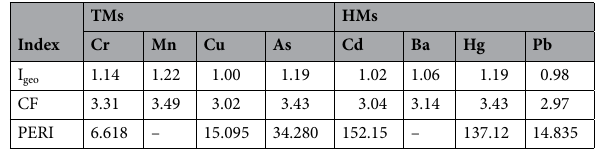
Table 5. Geo-accumulation index (I geo ), contamination factor (CF) and potential ecological risk index